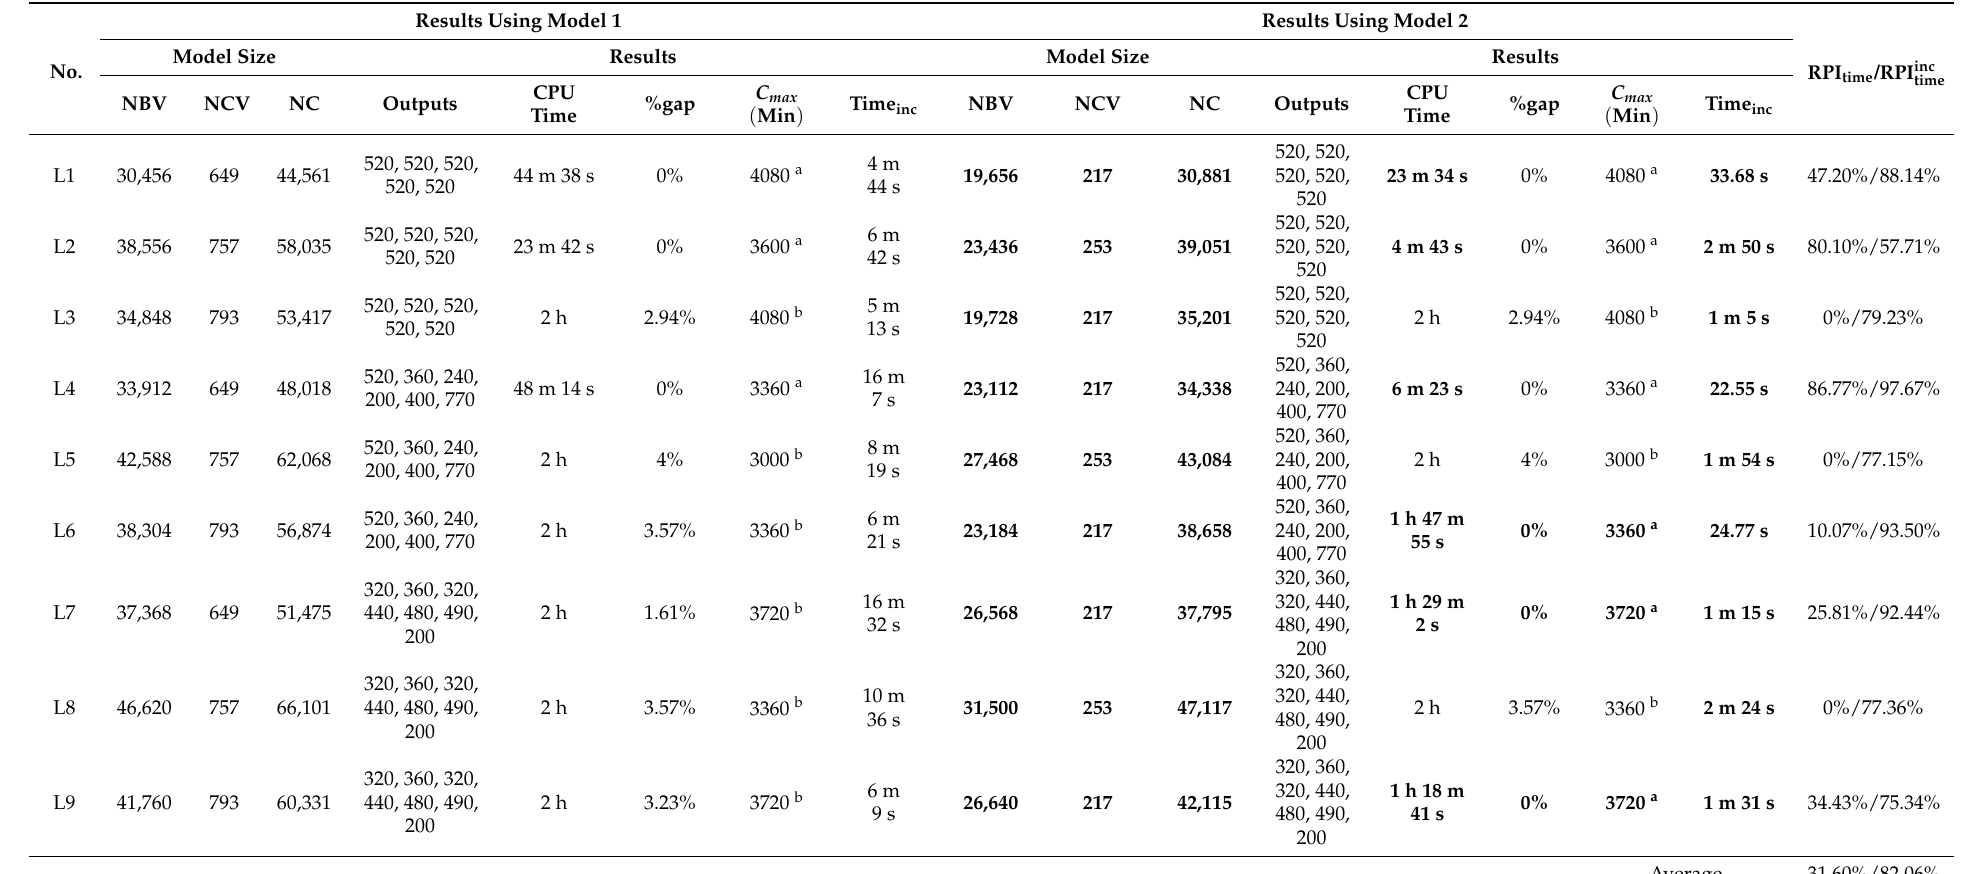
Table 12. Computational results of the large problems using Model 1 and Model